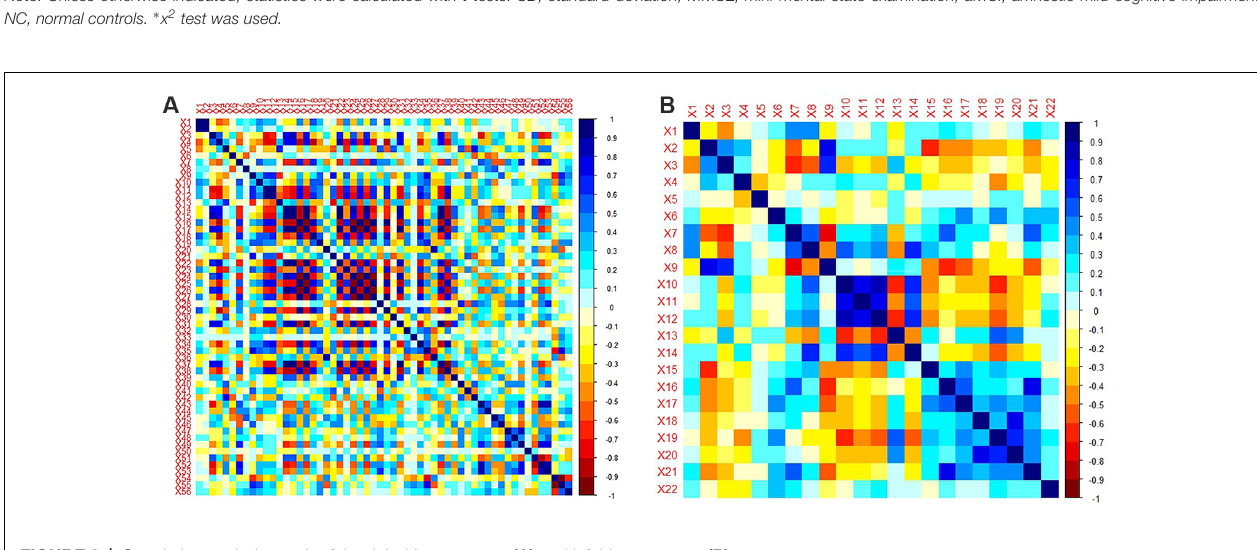
FIGURE 3 | Correlation analysis graph of the right hippocampus (A) and left hippocampus (B) .